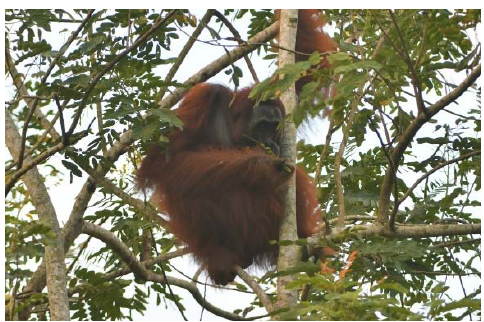
Figure 11. Adult male orangutan ( Pongo pygmaeus ) in reclamation post-coal-mining forest, eating the flowers and fruit of Johar ( Casia siamea ). Photo by Yaya Rayadin.